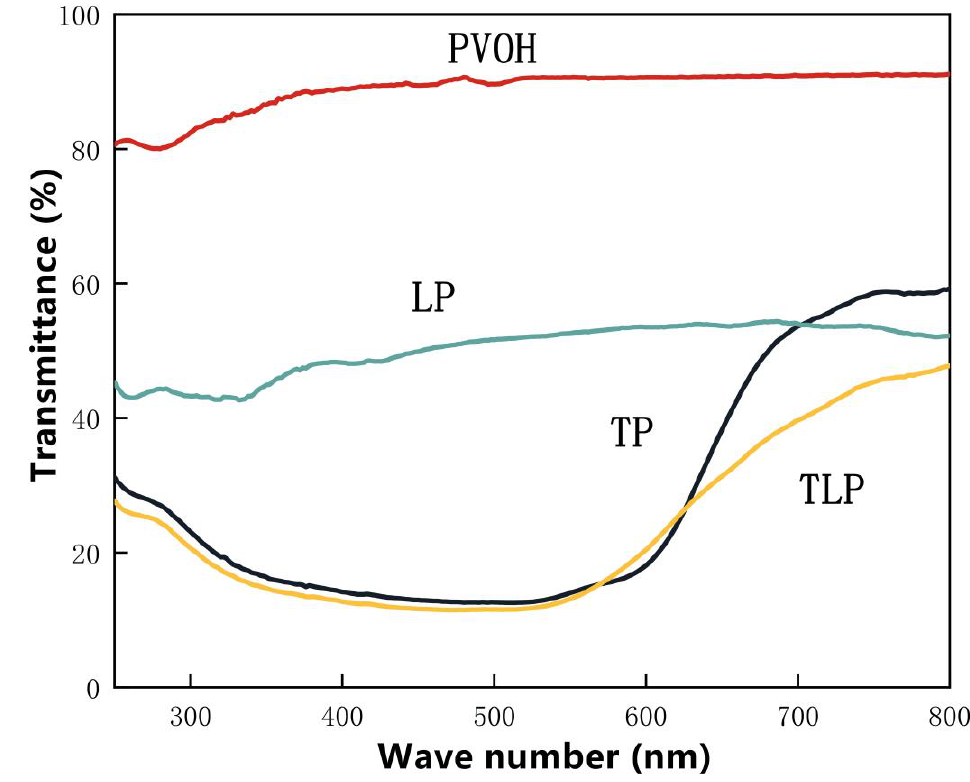
Figure 7 . Ultraviolet-visible (UV- VL ) transmittance of the various films. Figure 7. Ultraviolet-visible (UV- VL ) transmittance of the various